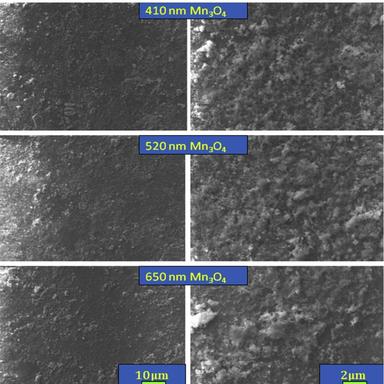
SEM images of the Mn3O4 films deposited by SILAR technique on the soda-lime-silica glass substrate with thicknesses of 410 nm, 520 nm, and 650 nm for two magnifications. The surface uniformity does not degrade with the addition of multiple SILAR cycles.